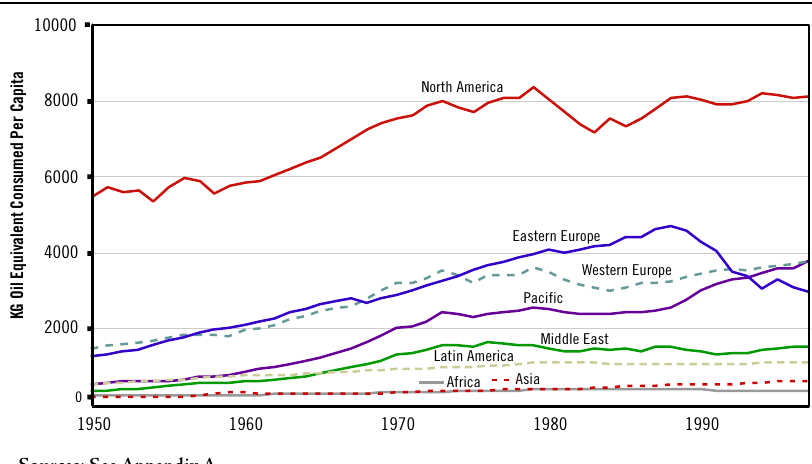
Figure 3 – Per Capita Commercial Energy Consumption,